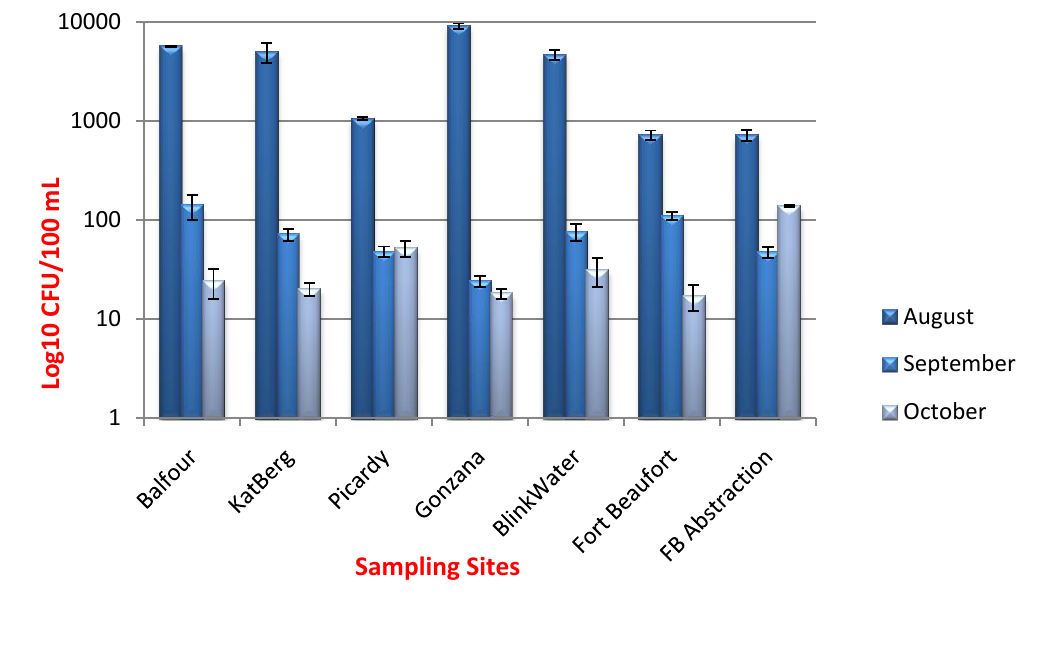
Figure 2. E. coli counts from all sampling sites for the month of August, September and